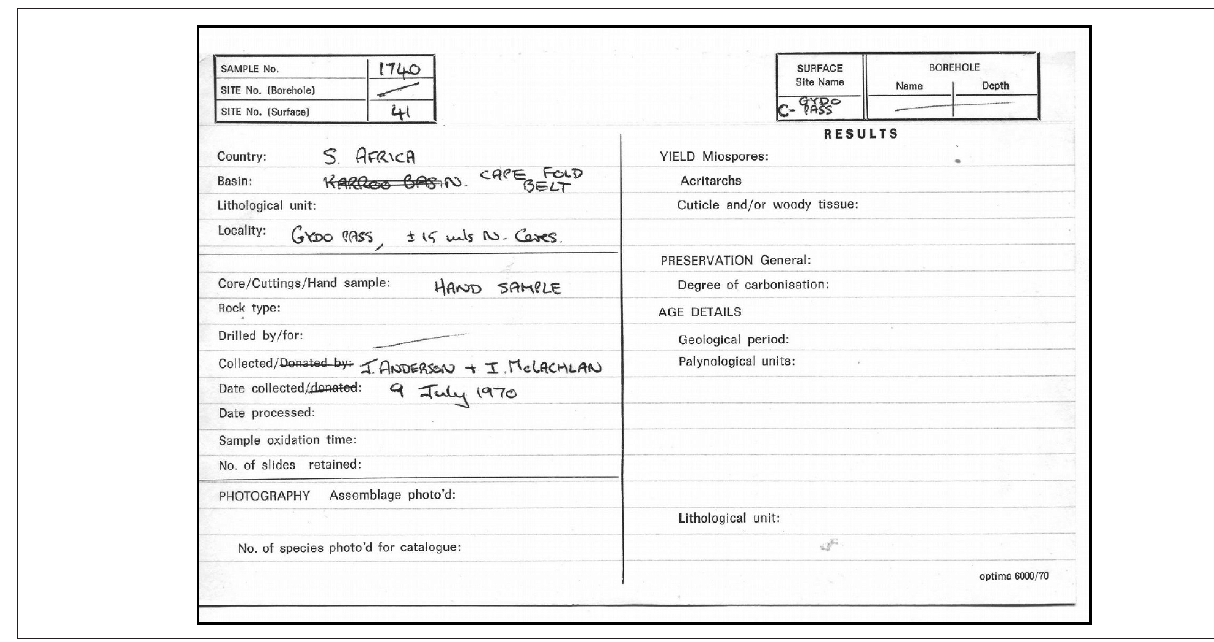
Summary of processes for presenting data within a spatial system